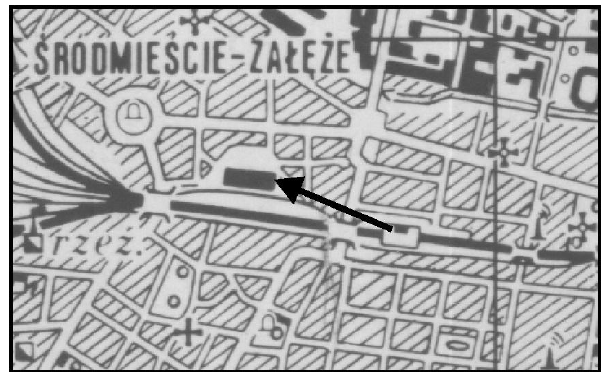
Fig. 5. Relocation of the railway station in Katowice (Source: a topographic map from the 1980s from the collection of State Archives in